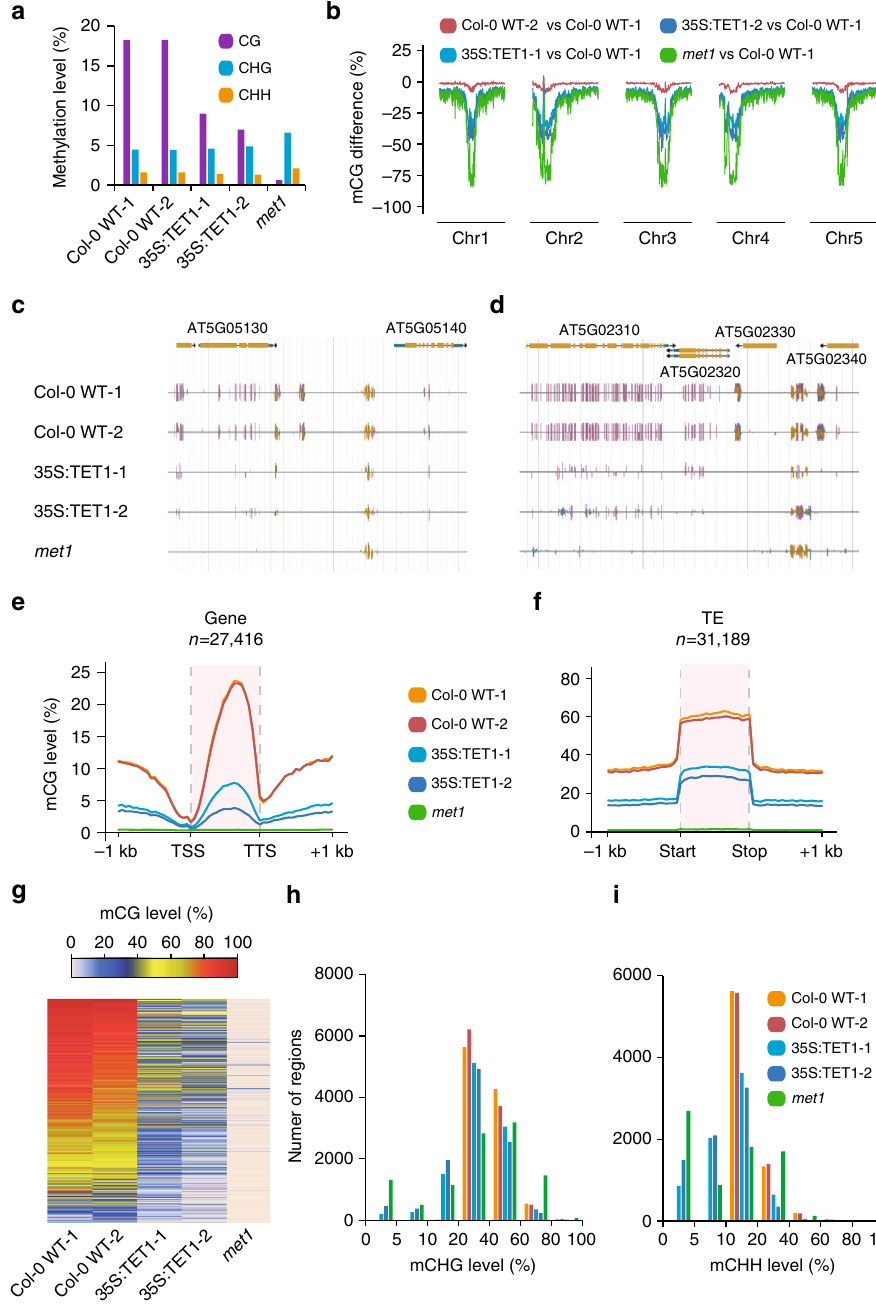
Fig. 1 Overexpression of hTET1cd-induced global CG demethylation in A. thaliana . a Bar graph of global methylation levels in two Col-0 WT replicates, two 35S:TET1 transgenic individuals, and met1 . b Metaplot of CG methylation levels (100 kb windows) across fi ve A. thaliana chromosomes. Methylation level differences were de fi ned relative to Col-0 WT-1, and Col-0 WT-2 was used to assess background interference. Genome browser view of methylome pro fi le of two regions ( c , d ) of the A. thaliana genome (purple vertical lines = CG methylation, blue vertical lines = CHG methylation, and gold vertical lines = CHH methylation). Metagene plots of CG methylation level across e gene bodies and f transposable elements. g Heat map of CG methylation level of CG DMRs. Bar plots of CHG ( h ) and CHH ( i ) methylation levels of CG DMRs that possess non-CG methylation in wild-type